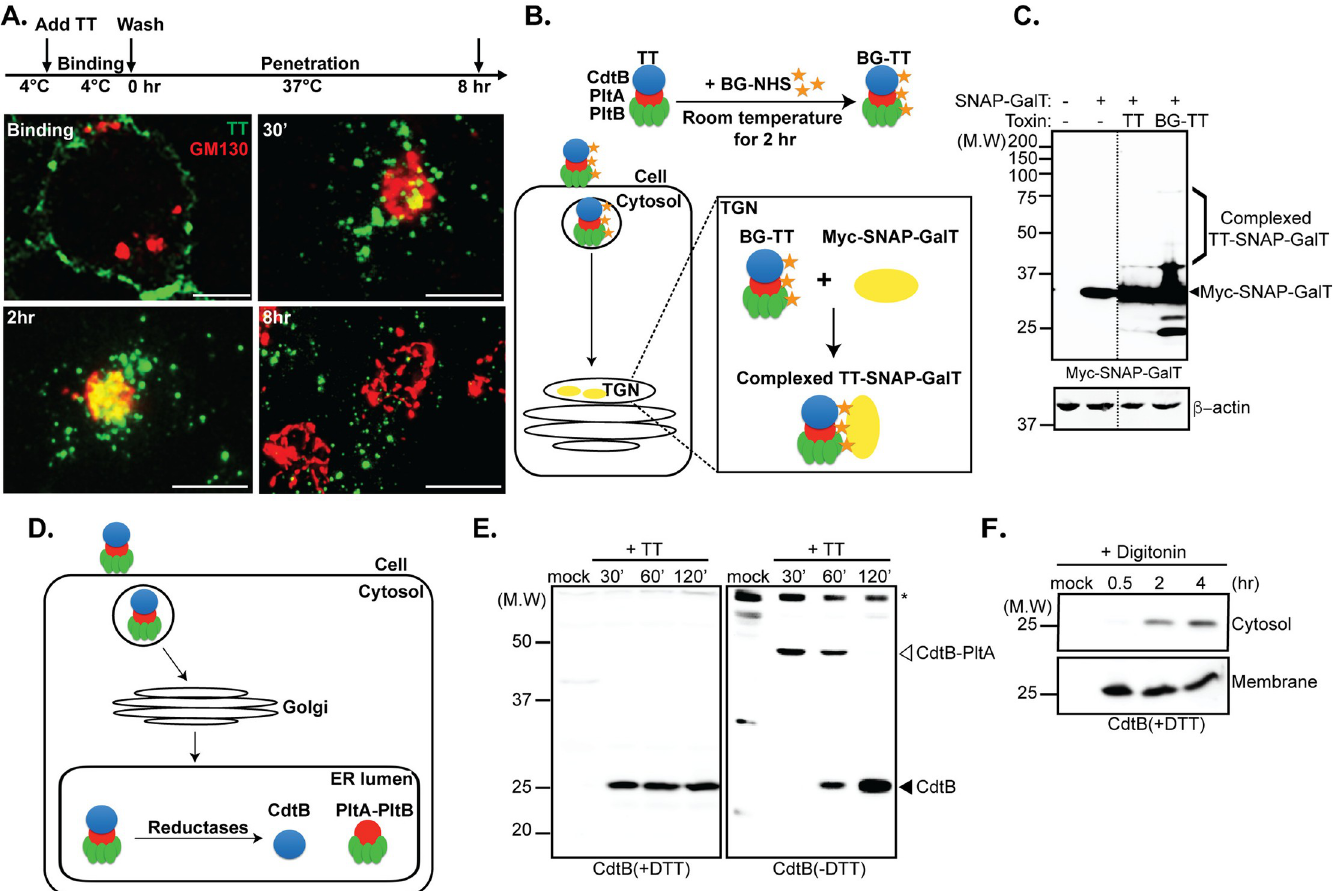
Fig 1. Typhoid toxin traffics to the ER by retrograde transport. (A) Tracking typhoid toxin (TT) transport by immunofluorescence microscopy. HEK293T cells were incubated with Oregon Green-488-labeled typhoid toxin (green) at 4˚C for 30 min, washed, and fixed with 4% paraformaldehyde (binding). Alternatively, after 30 min incubation at 4˚C, cells were washed, and then switched to 37˚C, incubated for 0.5, 2, and 8 hs and fixed as indicated above. Fixed cells were stained with an anti-GM130 antibody (red) and visualized by fluorescence microscopy. Scale bar, 5 μ m. (B and C) Typhoid toxin undergoes retrograde transport to the trans -Golgi network (TGN). (B) Schematic representation of the assay to detect typhoid toxin transport through the Golgi. (C) HEK293T cells transiently expressing myc epitope tagged SNAP-Galactosyl transferase 1 (Myc-SNAP-GalT) were treated with BG-NHS-labeled (BG-TT) or unlabeled (TT) typhoid toxin for 6 hr at 37˚C. BG-labeled toxin molecules that were “captured” by SNAP-GalT formed chimeric protein complexes (indicated as "TT-SNAP-GalT") that were detected by Western blot analysis with an antibody directed to the Myc epitope. Dotted lines indicate places where the experimentally relevant lanes were spliced together (all lanes originate from a single gel). (D and E) Typhoid toxin transport to the endoplasmic reticulum (ER). (D) Schematic representation of the typhoid toxin-disassembly assay in the ER. (E) HEK293T cells were treated with purified typhoid toxin for 30 min at 37˚C and lysed at the indicated time points. The mobility of typhoid toxin in SDS-PAGE in the presence or absence of DTT (as indicated) was then analyzed by Western blot with an antibody to CdtB. The positions of CdtB and the CdtB-PltA heteromeric complex are indicated. � denotes the migration of a non-specific cross-reacting protein (F) Typhoid toxin retro-translocation from the ER to the cell cytosol. HEK293T cells were incubated with purified typhoid toxin at 37˚C and then harvested at the indicated time points. Cells were selectively permeabilized with digitonin and the presence of typhoid toxin in the cytosolic fraction was detected by Western blot analysis with an antibody to CdtB.